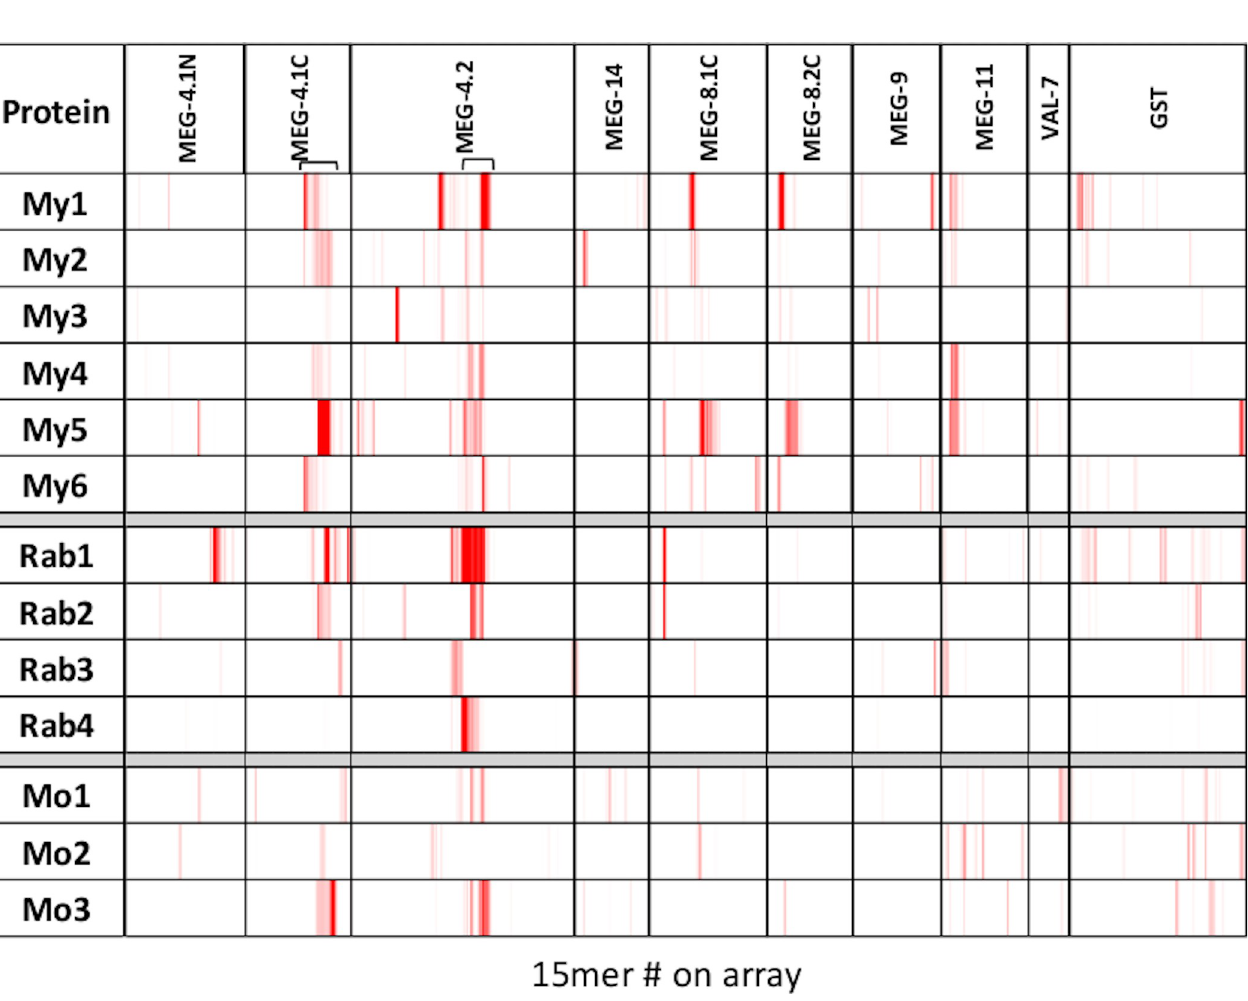
Fig 4. Heatmap of Array 1b. The array was reacted with six macaque (My) four rabbit (Rab) and three mouse (Mo) infection sera, all at 1:100 dilution. Location of the protein targets represented on the array by overlapping 15mer peptides is shown on the header. The heatmap is plotted on a scale of 1000 to